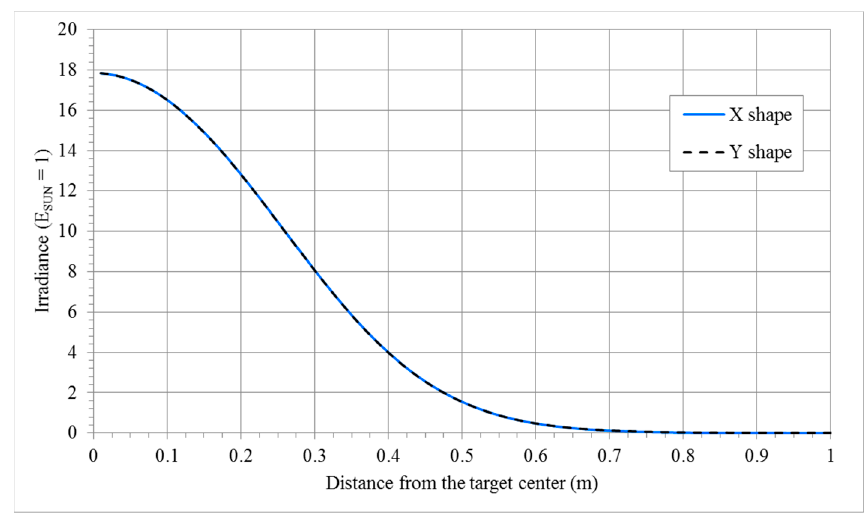
Figure 12. Target irradiance for a 5 × 5 heliostat field with row distance 4 m and column distance 3 m.